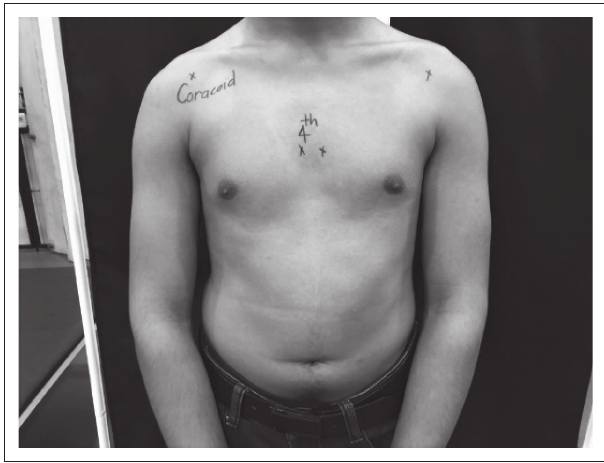
FIG URE 1: Pectoralis minor landmarks.